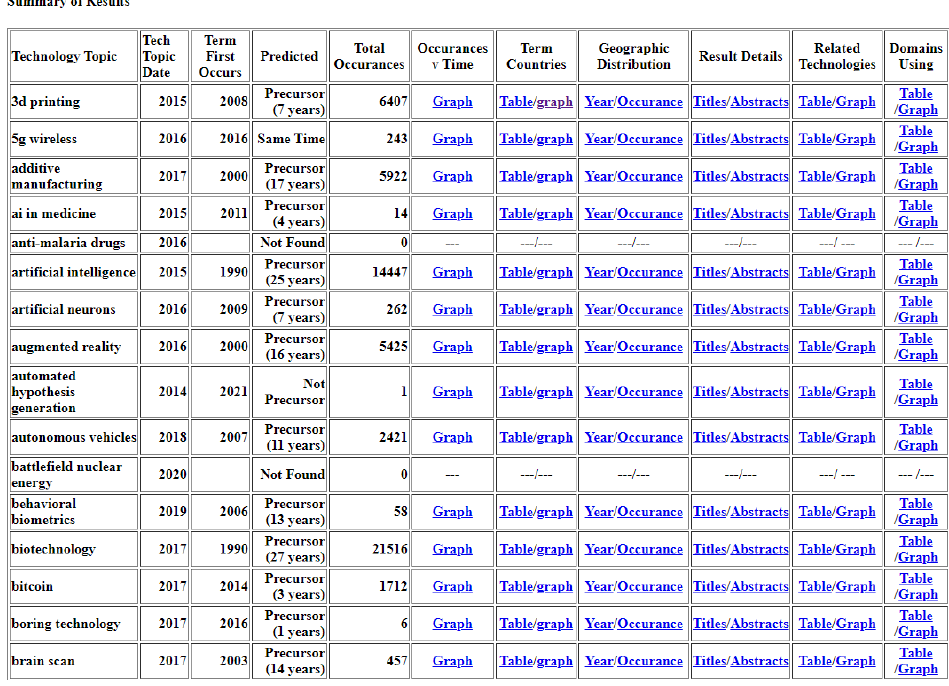
Figure 7. Analysis summary and links page (HTML).